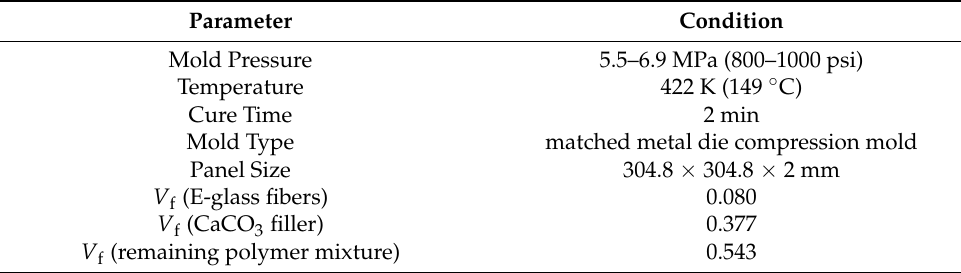
Table 2. Compression molding parameters.